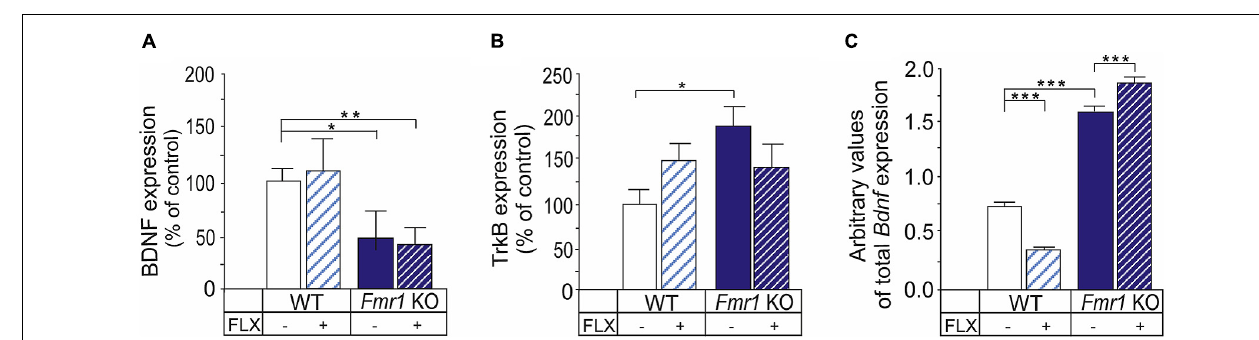
that of Fmr1 KO mice. (B) The effects of long-term fluoxetine treatment were examined on hippocampal cell proliferation analyzed by incorporation of BrdU in newborn cells. (C) Fluoxetine increased significantly hippocampal cell proliferation in wild type but not in Fmr1 KO mice after fluoxetine treatment. Error bars indicate means + SEM. ** P < 0.01, *** P < 0.001.